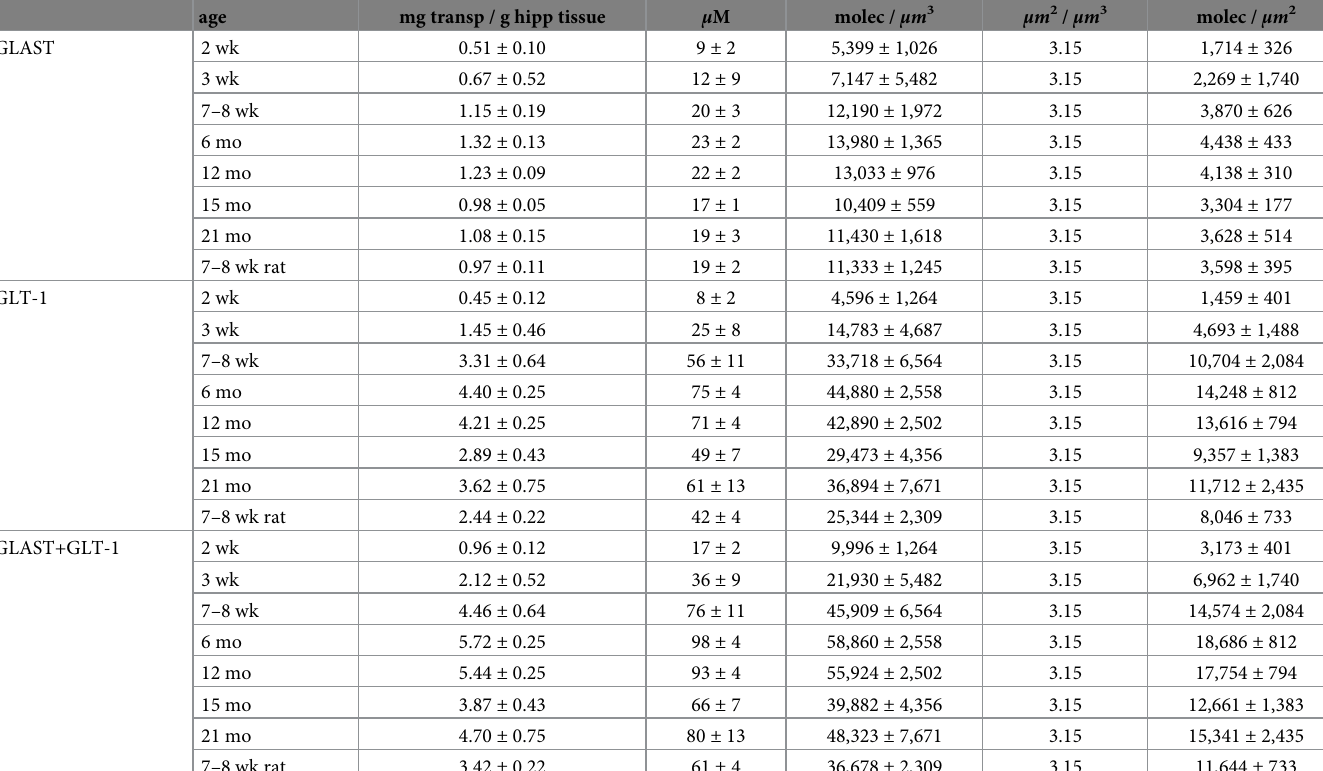
Table 4. Tissue concentrations of glutamate transporters. The number of molecules of GLAST or GLT-1 per volume of hippocampal tissue and per cell membrane area were calculated from the dot blot experiment using the following assumptions: the mouse hippocampus contains 97.8 g of protein per Kg of tissue [68], has a density of 1.05 g/ cm 3 [69], and that the molecular weigh of GLAST and GLT-1 are 59,619 and 62,027 Da, respectively (mean ± SD; n = 3). The astrocyte plasma membrane density was set to 3.15 μm 2 / μm 3 for mice (according to measures obtained from our 3D axial STEM tomography data) and rats (see Results section for details).